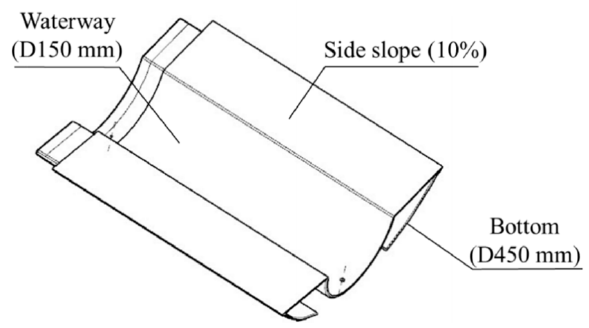
Figure 2. A complex cross-section module for the D450 mm sewer